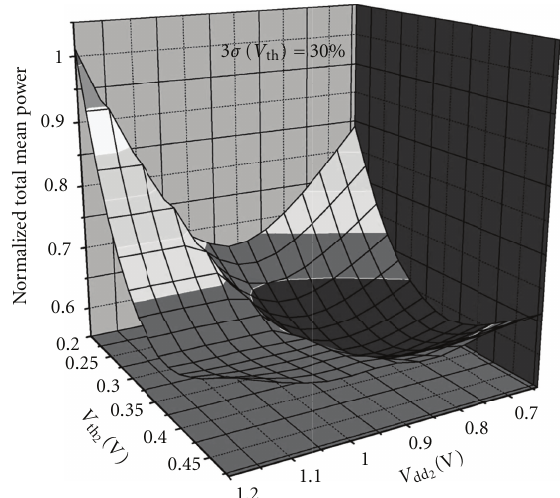
Figure 3: Optimal selection of dual threshold and supply voltages under process variation.